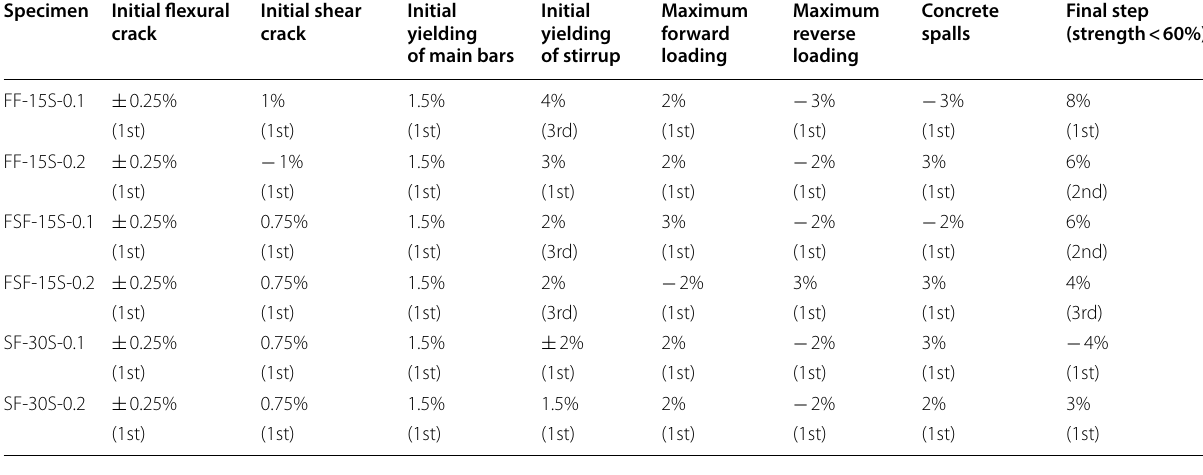
Table 6 Performance points of each specimen under cyclic loading.